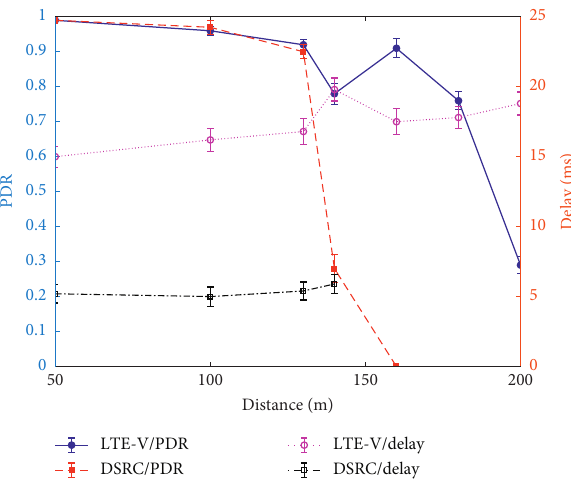
Figure 12: The results of performance in the building-shielding